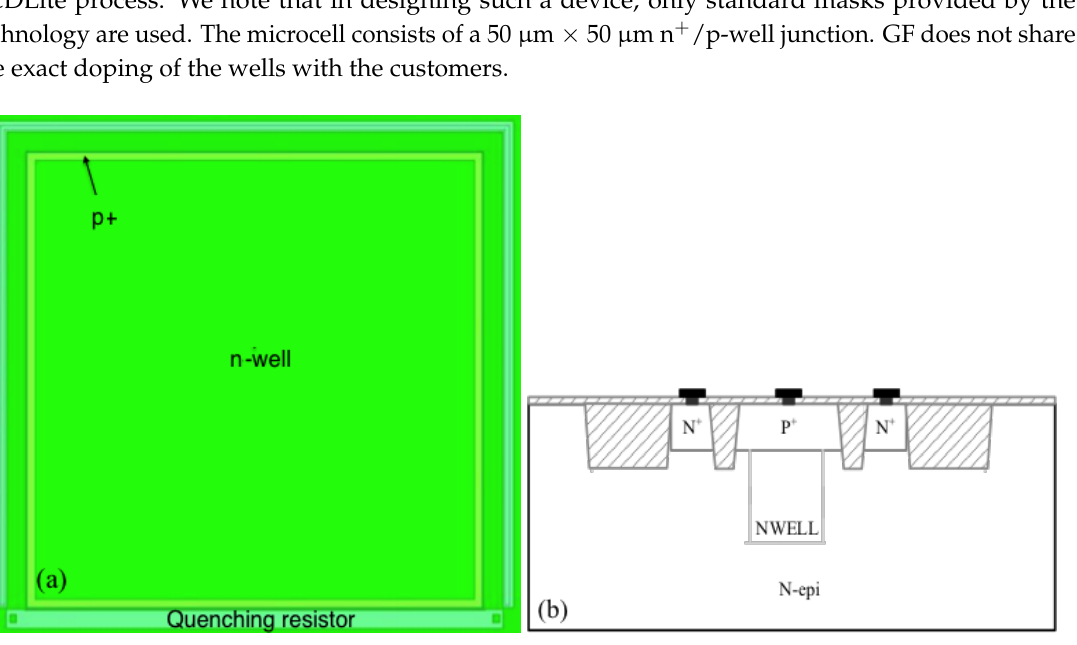
Figure 2. ( a ) Layout of a SiPM microcell in GLOBALFOUNDRIES (GF) 180 nm BCDLite process; and ( b ) cross-section of the microcell